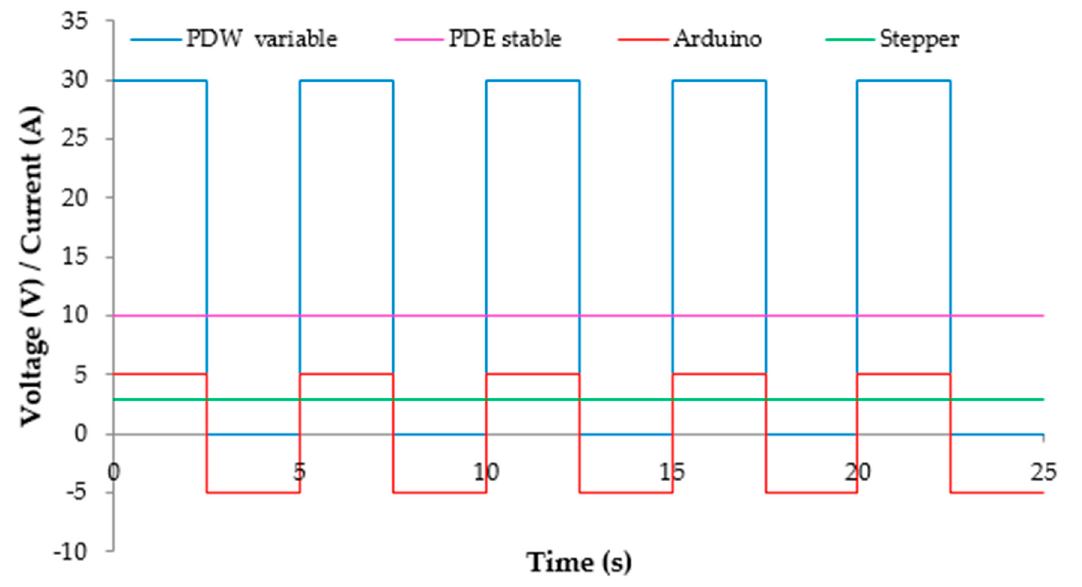
Figure 4. Response of the simulation of stepper motor performance.